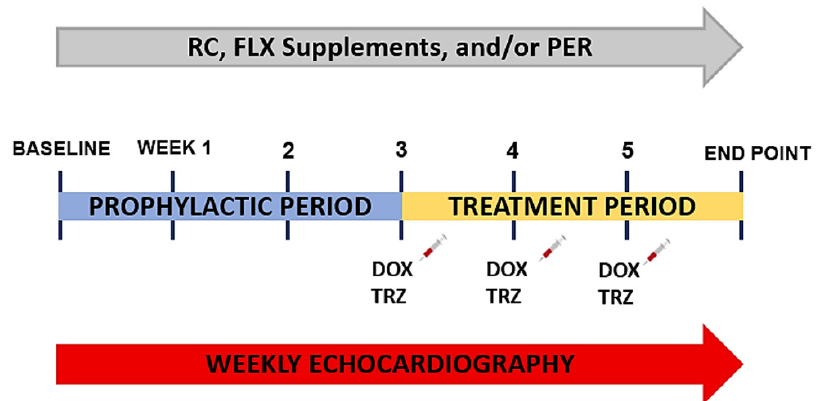
Figure 1. Experimental scheme. Mice received ad libitum access to their RC- or FLX-supplemented diets daily starting at baseline for the entirety of the 6-week study. At the start of week 4, mice were further randomized to receive weekly intraperitoneal injections of 0.9% saline or DOX (8 mg/kg) + TRZ (3 mg/kg) to induce a chronic state of chemotherapy-induced cardiotoxicity. Cardiac function was assessed weekly using non-invasive echocardiography. At study endpoint, cardiac tissues were harvested for both histological and biochemical analysis. DOX, doxorubicin; FLX, flaxseed; PER, perindopril; RC, regular chow; TRZ, trastuzumab.